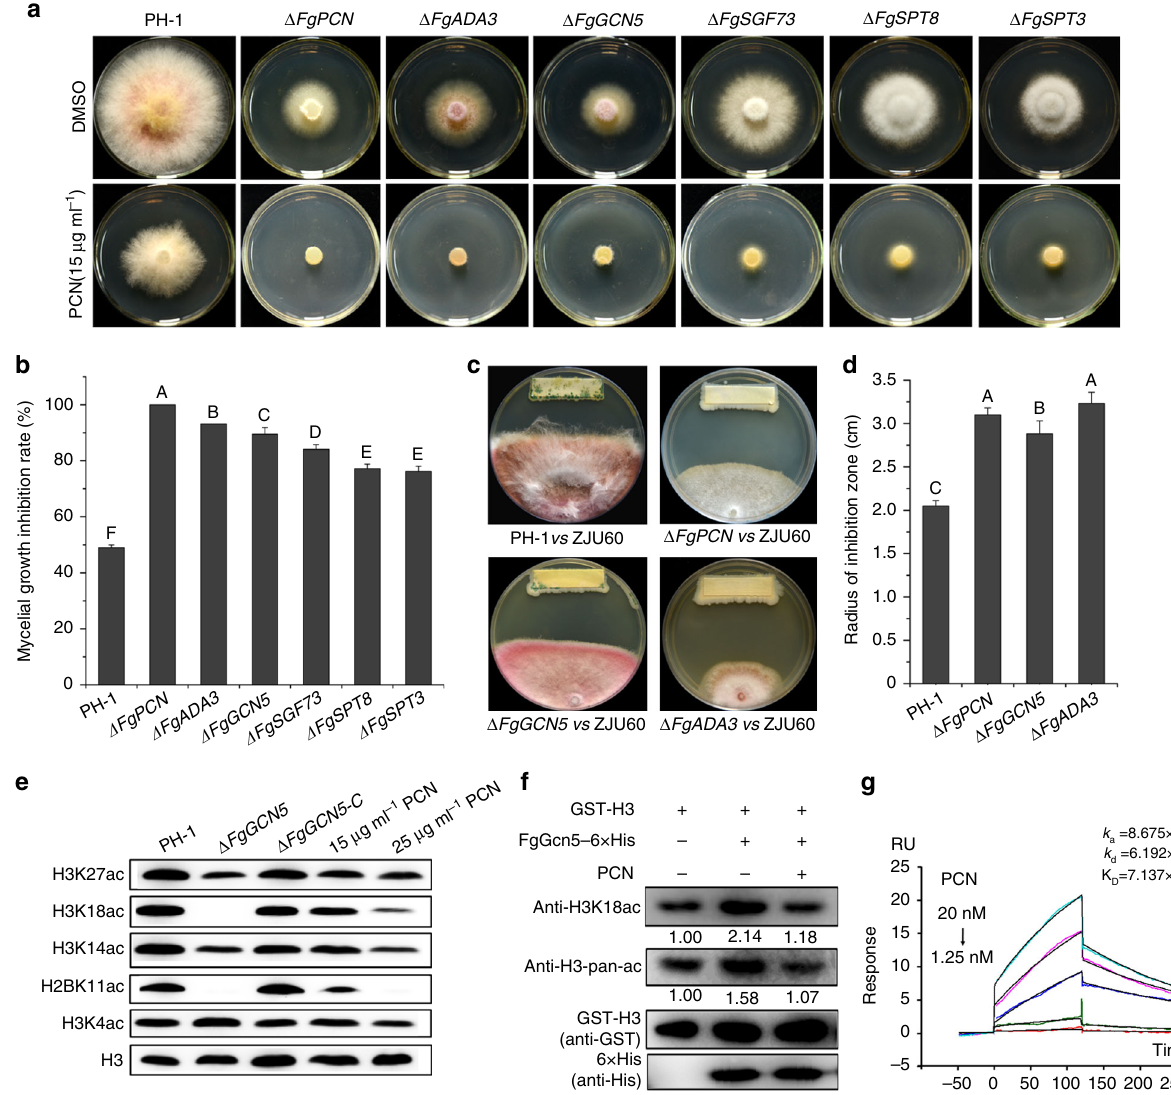
Fig. 4 PCN targets the acetyltransferase FgGcn5 of the SAGA complex in Fg. a PCN sensitivity of deletion mutants for the six key components of the SAGA complex. b The mycelial growth inhibition rate was calculated after 3 days of incubation. c Antagonistic activity of ZJU60 towards wild-type PH-1 and Δ FgPCN , Δ FgADA3 , and Δ FgGCN5 mutants. d The radius of the inhibition zone was measured after 5 days of incubation. Data presented are the mean ± s.d. ( n = 3). The same letter on the bars for each column indicates no signi fi cant difference according to a LSD test at P = 0.01. e Effects of FgGcn5 deletion and PCN treatment on histone acetylation. Several antibodies against speci fi c lysine (K) acetylation (ac) sites on histones were used to detect histone acetylation in western blot analyses. Hybridization with an anti-H3 C-terminus antibody served as a loading control. f Inhibition of activity against the acetyltransferase activity of FgGcn5 on H3 and H3K18 in vitro. Puri fi ed recombinant GST-H3 was incubated with FgGcn5-6xHis in HAT buffer with or without PCN for 45 min at 37 °C and then immunoblotted with the indicated antibodies. The relative intensities of H3K18ac and H3-pan-ac bands were quanti fi ed with ImageJ, and the fold-change relative to that of without FgGcn5 control is indicated below the bands. The bands in the control reaction (without 6xHis-FgGcn5) were set as 1.00. g SPR analysis of PCN binding to FgGcn5. SPR kinetic sensorgrams (colored lines) and fi tting curves (black lines) for PCN binding to FgGcn5 at different concentrations (from top to bottom: 20, 10, 5, 2.5, 1.25 nM). The responses were reference-subtracted,